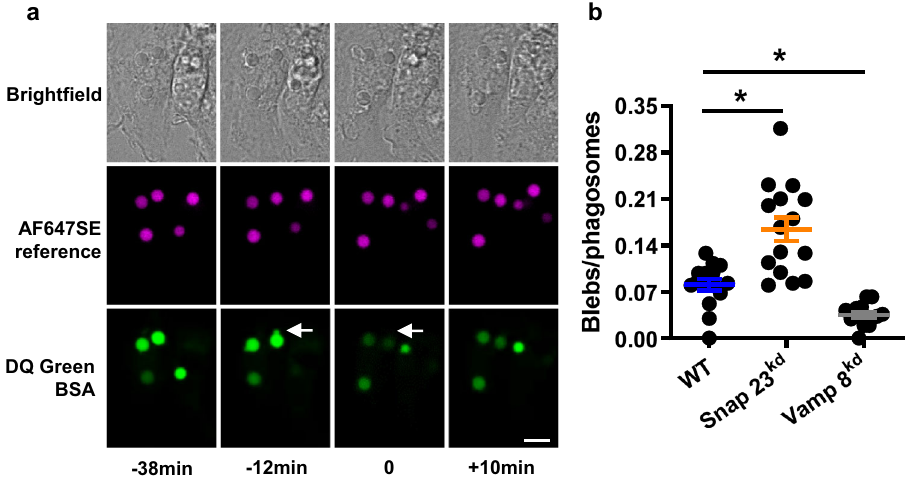
Fig. 7 Eructophagy is preceded by blebs on the phagolysosomal membrane. a Representative sequential images of BMMØs following the phagocytosis of experimental particles bearing the quenched DQ Green BSA substrate (green), the pH indicator pHrodoSE (red) and the reference fl uorophore AF647SE (magenta). Phagolysosomal morphology can be visualized in the green channel as the soluble DQ Green BSA peptide products are not particle-restricted and hence occupy the entire phagolysosomal lumen. Arrow shows a ~0.5 μ m diameter bleb of the phagolysosomal membrane commonly observed before an eructophagic event (observed as the sudden loss of soluble DQ Green BSA peptide products to the extracellular space). Images were captured using a Leica SP5 confocal microscope between 1 and 3 h post-phagocytosis at 37 °C. b Quanti fi cation of the number of blebs per phagolysosomes following the phagocytosis of experimental particles bearing the self-quenched DQ Red BSA (red) and the reference fl uorophore AF647SE (magenta). N = 15; 5 fi elds of view (FOV) over three biologically independent experiments. Error bars presented as means ± SEM. * P ≤ 0.05 by one-way ANOVA with Bonferroni ’ s post hoc test. Source data are provided as a Source Data fi le. formyl-peptides, U937 cells constitutively expressing human phagolysosomes containing reporter particles with tethered FPR-1 (FPR1-U937) were loaded with the calcium indicator formyl-peptides triggered robust calcium fl uxes in vicinal FPR1- Fluo-4 AM and allowed to interact with macrophages that had U937 cells with a high degree of spatial and temporal association previously phagocytosed reporter particles with tethered formyl- (Fig. 10b and Supplementary Movie 10). To further demonstrate peptides (Fig. 10a). As anticipated, eructophagic events of the relationship between eructophagy and PAMP-activation of